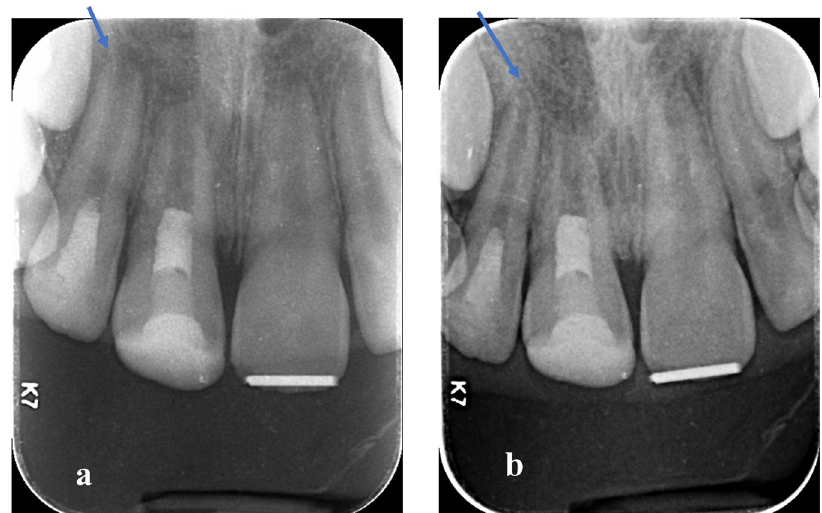
Fig. 7 Digital periapical radiographic images of immature upper right lateral incisor representative for Group (N) showing continuing root lengthening. a Baseline immediate post-operative radiograph showing the immature root of upper right lateral incisor. b 12 months follow-up radiograph showing the increase in root length in upper right lateral